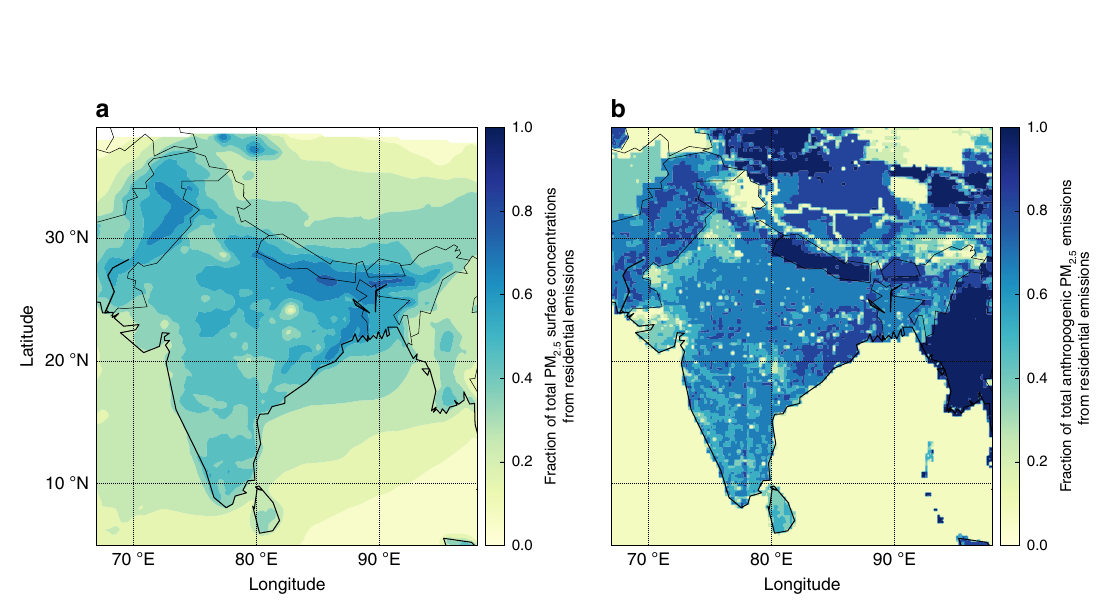
Fig. 2 Fractional contribution of residential energy use to annual mean PM 2.5 . a Concentrations. b Anthropogenic emissions. Emissions are from EDGAR- HTAP v2.2 (see